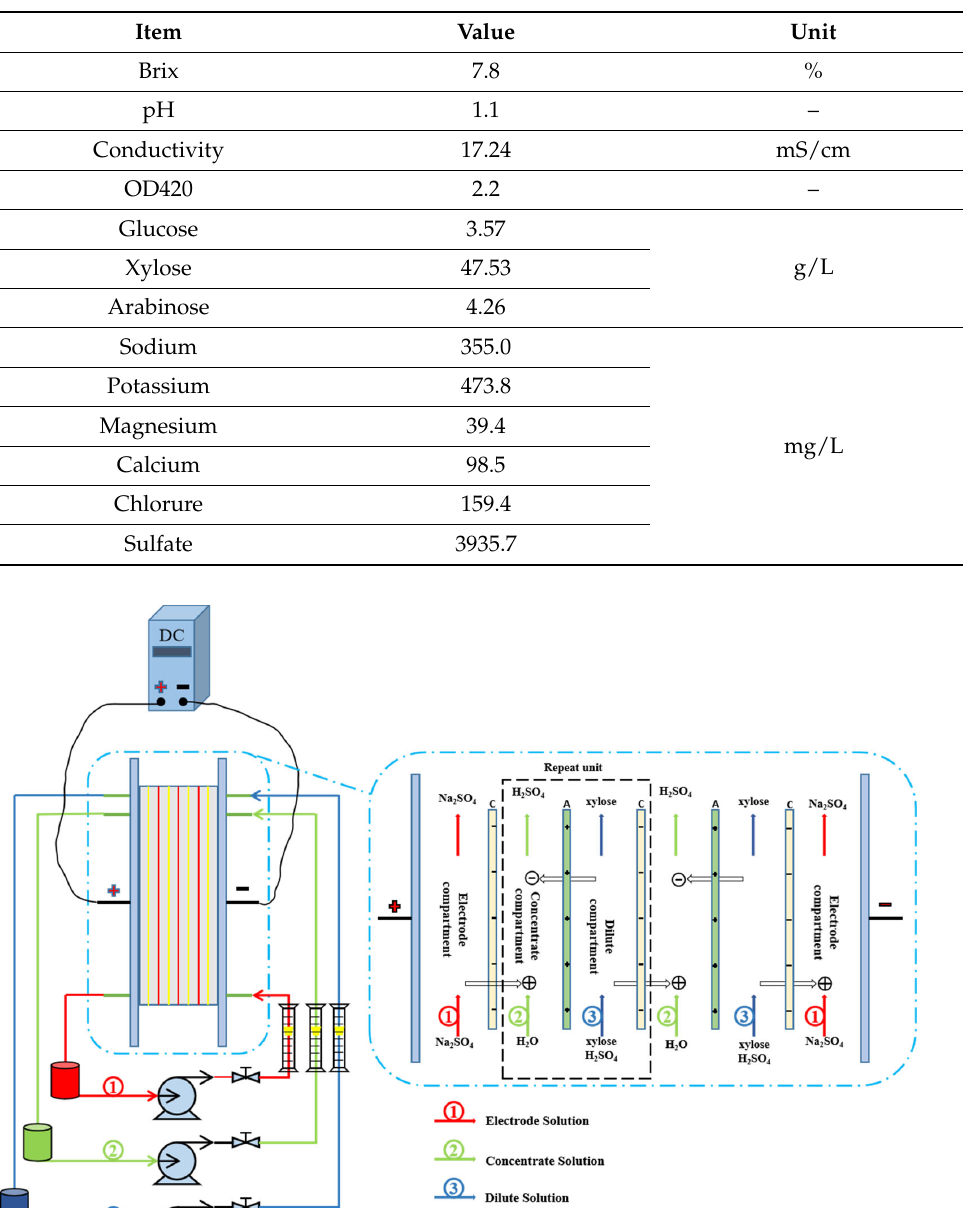
Table 1. Physic-chemical properties and composition of the CAH feedstock.